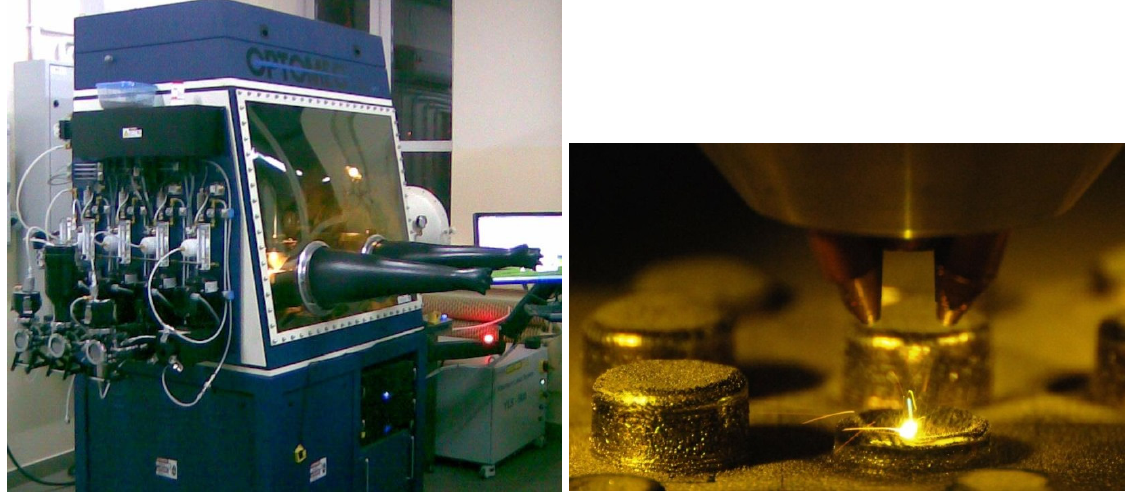
Figure 1. MR7-Laser Engineered Net Shaping